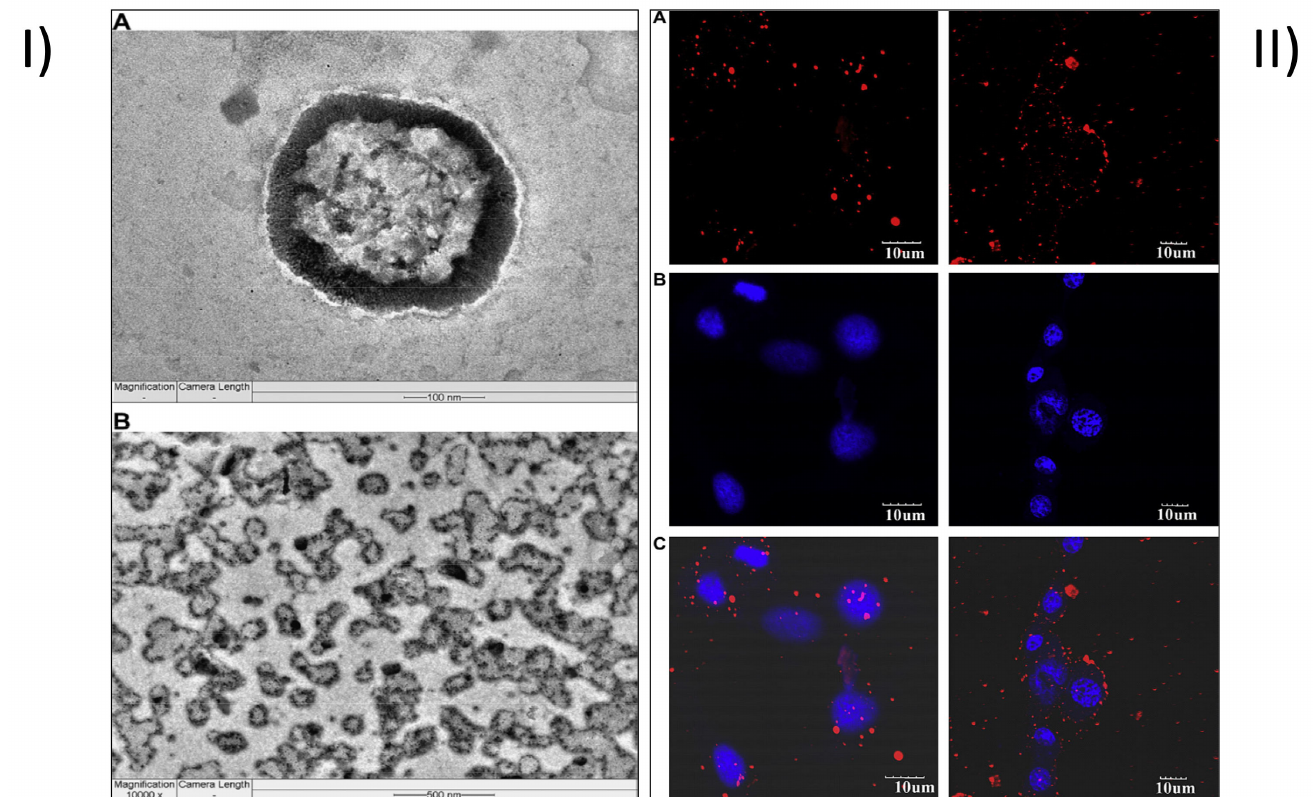
Figure 7. ( I ) FETEM images of QDs; ( A ) liposomes filled with separate QDs and coated with TPGS, ( B ) multiple QDs loaded TPGS coated liposomes ( II ) CLSM photograph of MCF-7 cells ( A ) The red fluorescence of liposomes in the cytoplasm is depicted by quantum dots; ( B ) DAPI channels; ( C ) Merged channels of QDs and DAPI. Reproduced with permission from Ref. [9], Figures 3 and 6. (Elsevier ©